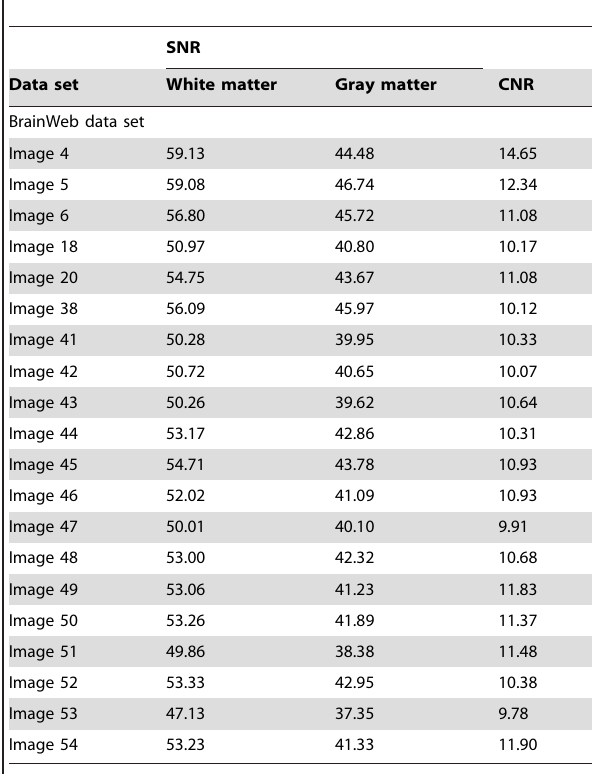
Table 1. Image quality parameters of the BrainWeb data